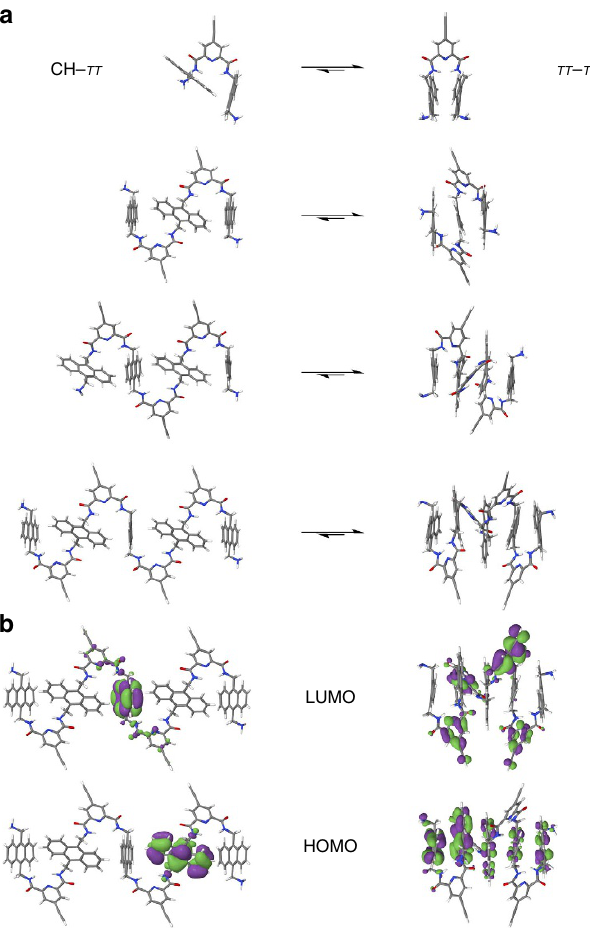
Figure 4 | Computed structure of the foldamers. ( a ) Representative CH– p and p – p structures for the different foldamers. ( b ) HOMO and LUMO orbitals for CH– p and p – p conformers of pentamer-NH 2